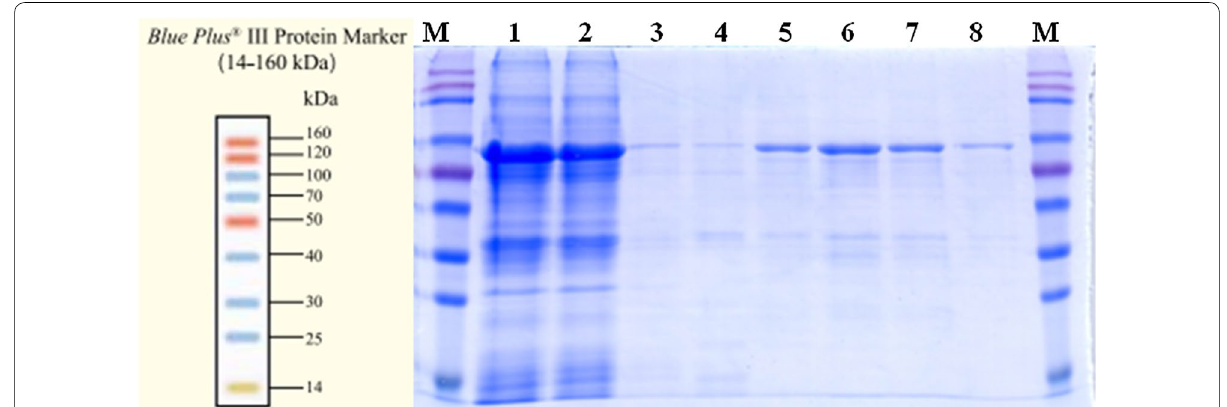
Fig. 2 10% SDS-PAGE of Bgl.bli1. Lanes 1 and 2, total protein of cells induced with IPTG; lanes 3–8, purified recombinant